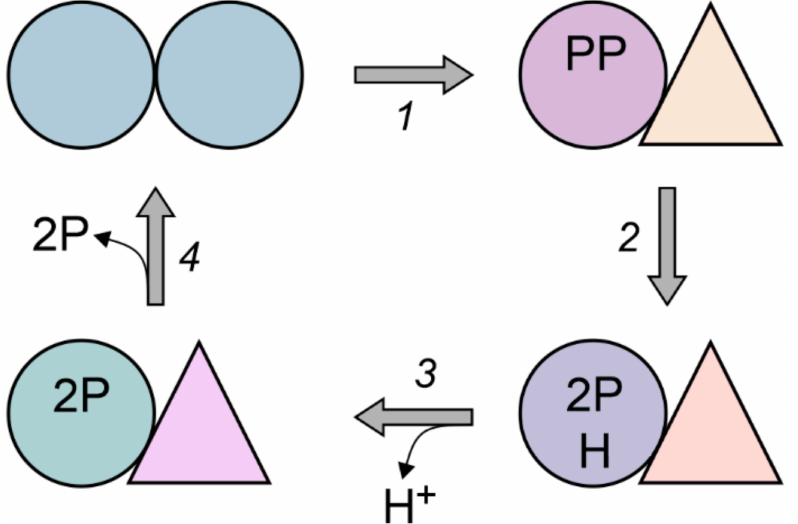
Figure 7. A hypothetical model of the conformationally coupled PP i hydrolysis and H + transport in dimeric mPPase. PP is pyrophosphate, P is phosphate, and H is proton. Subunits are shown as different geometrical shapes and colors, which characterize their structure and energy